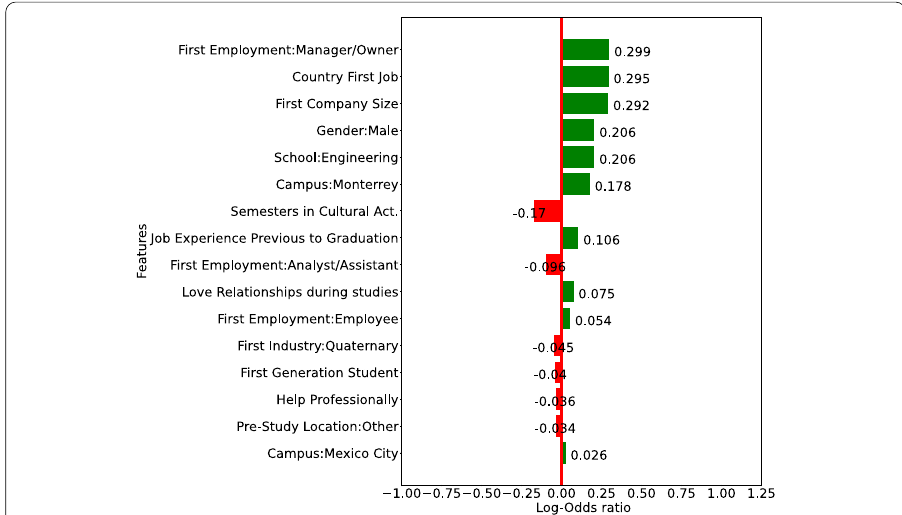
Fig. 14 First Income LR Feature Importance with coefficient weights